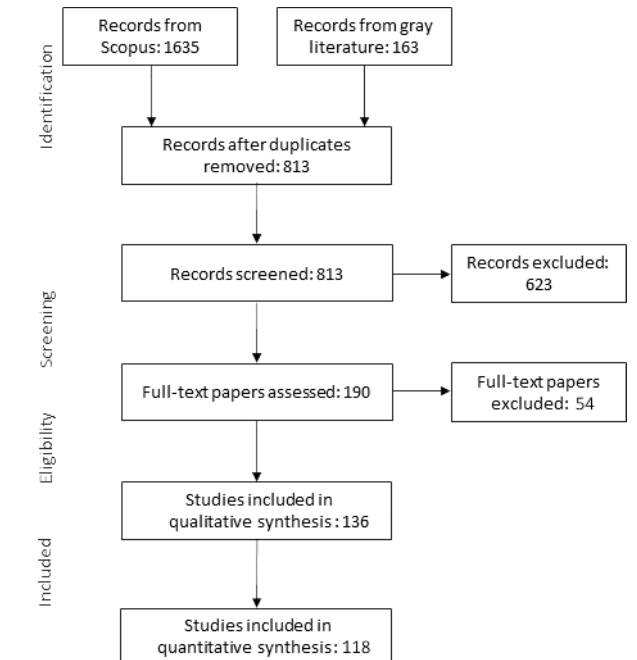
Figure 1. Flowchart summarizing the results of the literature search based on the PRISMA